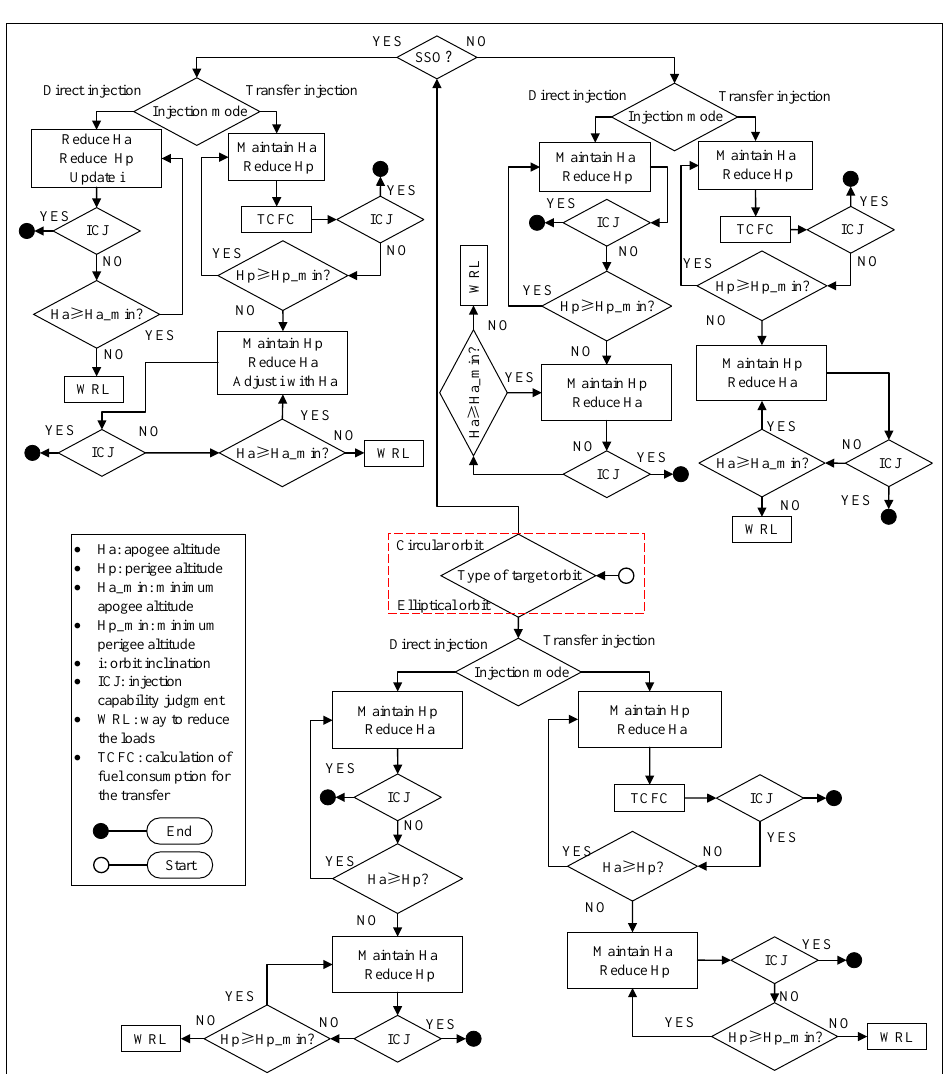
Figure 1. Orbit-injection strategy based on target degradation rules.